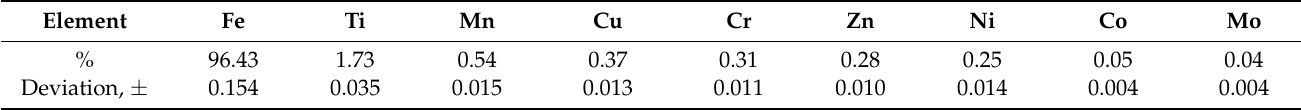
Table 1. Results of determining of the steel chemical composition.